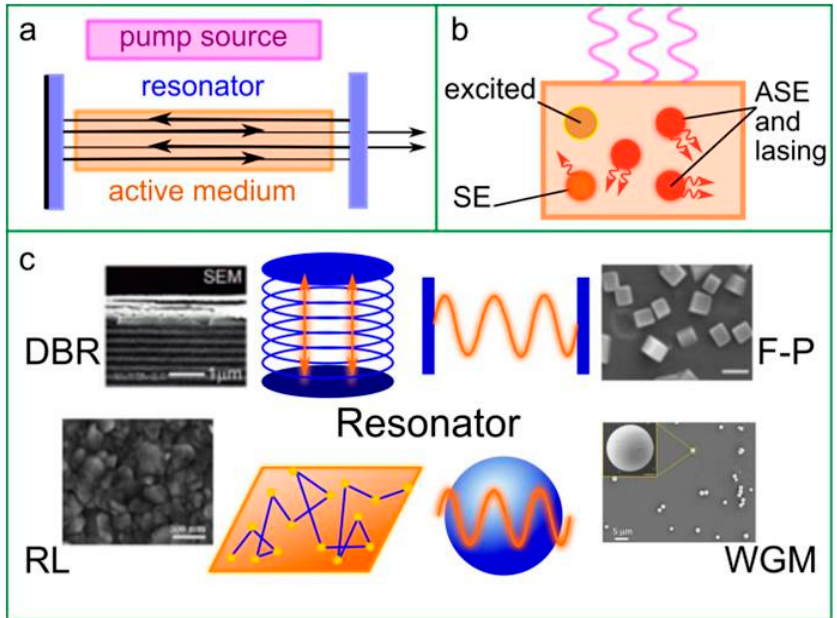
Figure 5. Architecture of perovskite-based lasers. ( a ) Simplified laser configuration. ( b ) Principle of stimulated emission occurred in active media: SE—spontaneous emission, ASE—amplified spontaneous emission. ( c ) Types of resonator’s geometries: DBR—distributed Bragg reflector, F-P—Fabry–Perot, RL—random lasing, WGM—whispery gallery mode. Insets in (c) are the examples of the